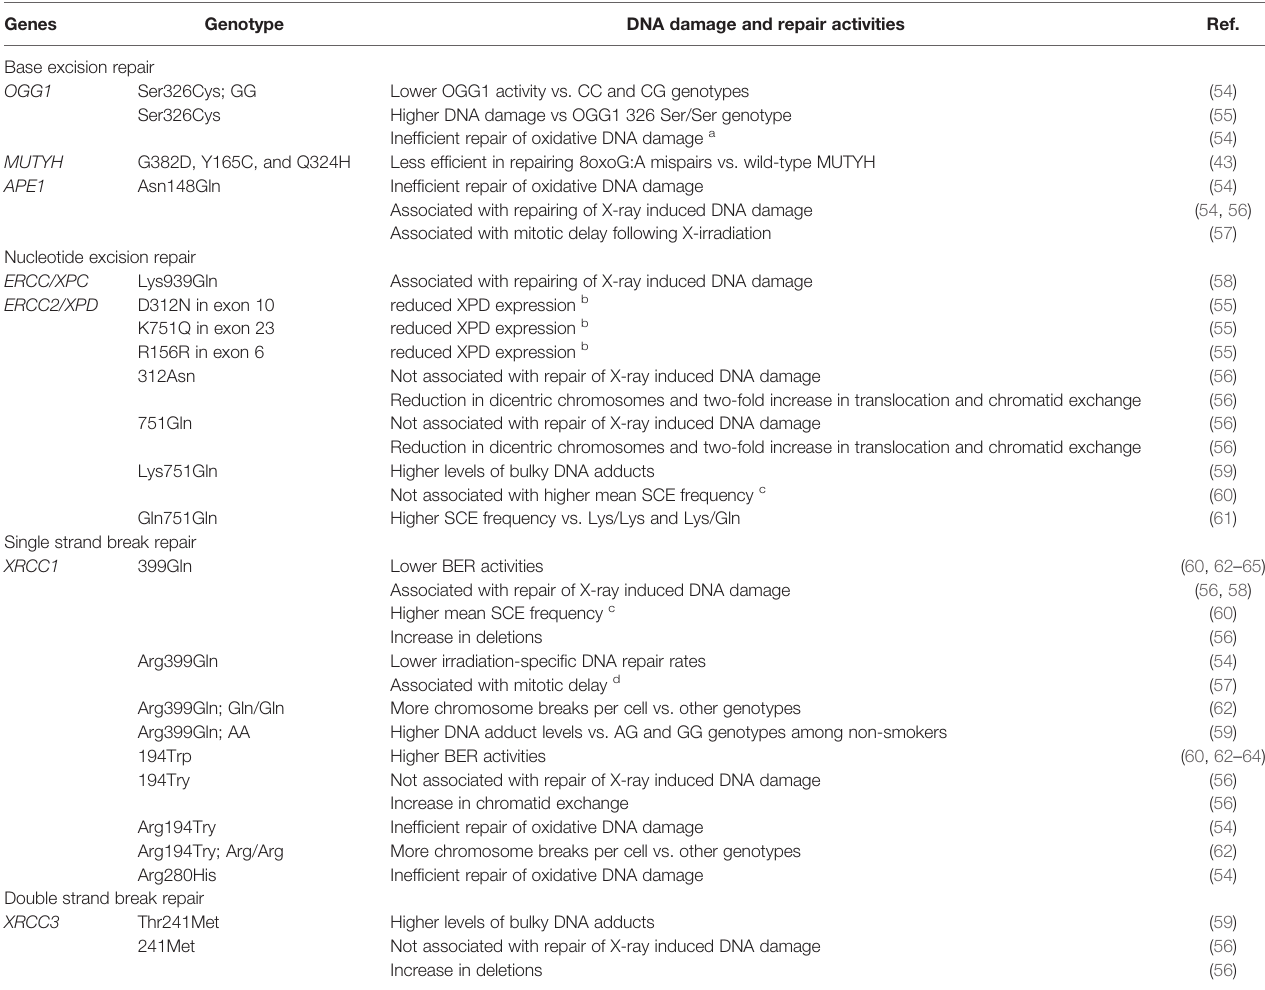
TABLE 1 | Polymorphism in DNA repair genes and their association with genome integrity. Genes Genotype DNA damage and repair activities